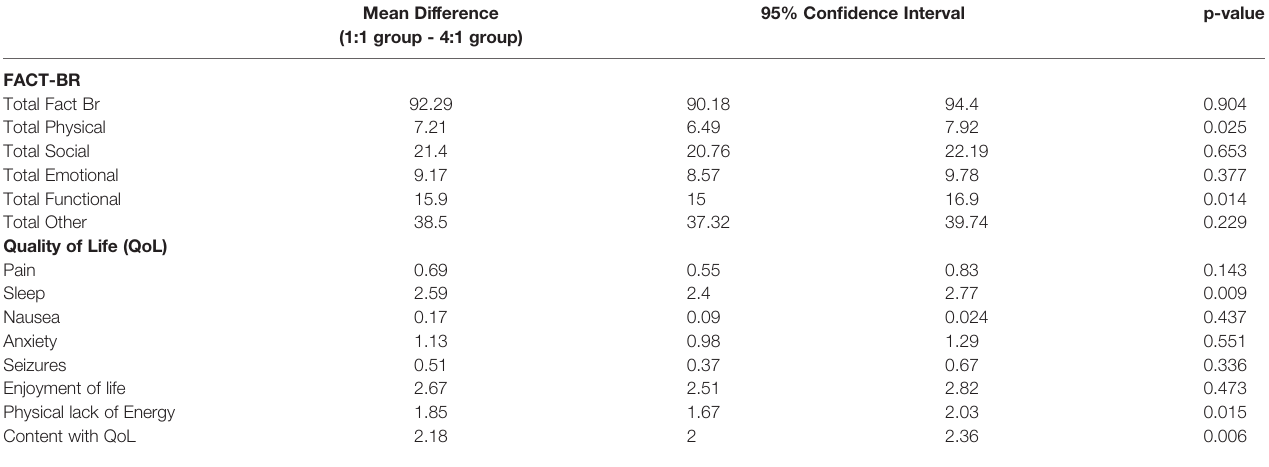
TABLE 3 | Paired T-test from Baseline to Week 12 Comparing 1:1 to 4:1 (FACT-BR). Mean Difference p-value (1:1 group - 4:1